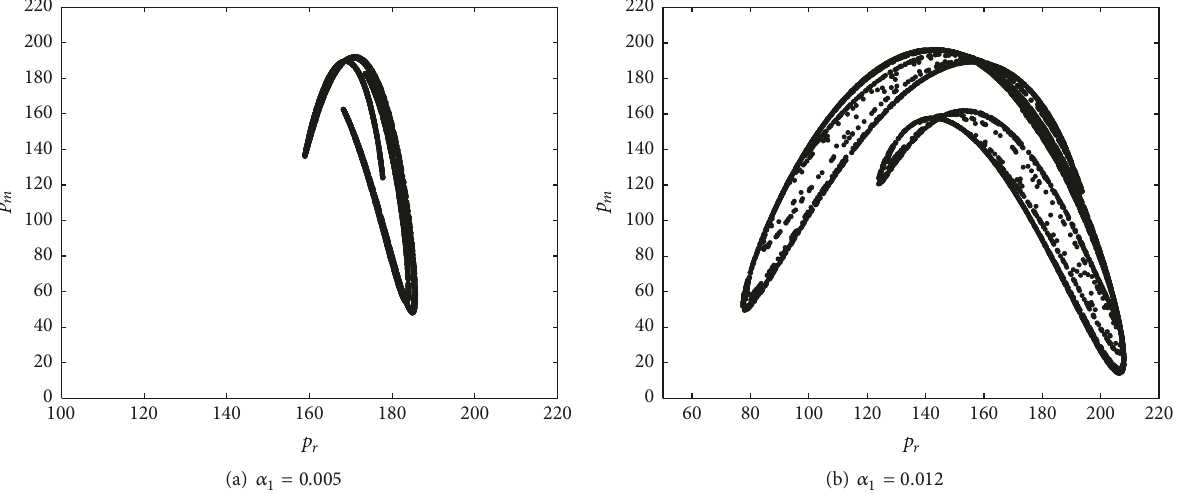
Figure 4: Chaotic attractors of the system when 𝛼 2 = 0.022.